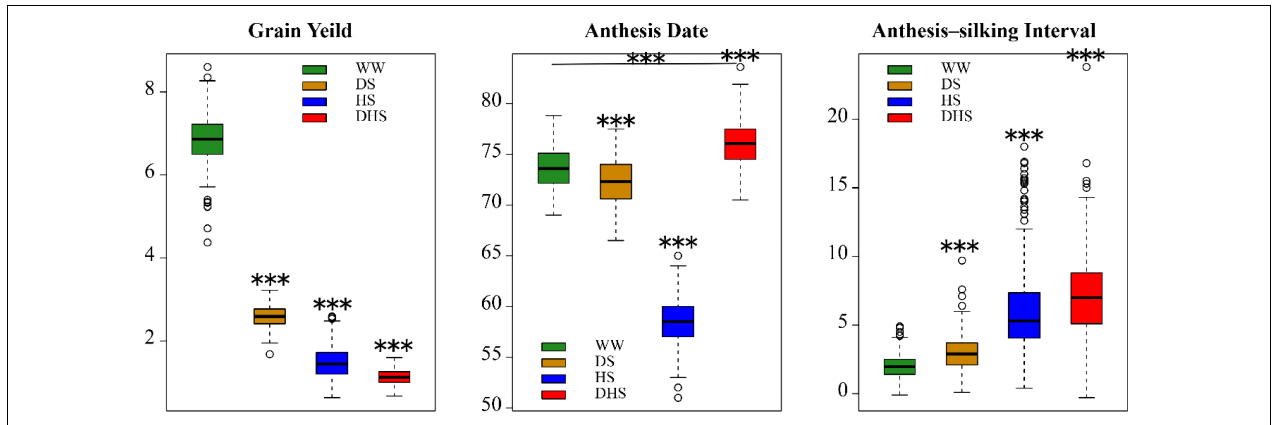
FIGURE 1 | The boxplots of the phenotypic distribution of all the 12 target trait-environment combinations between the three target traits, i.e., grain yield (ton/hectare); anthesis date (day); anthesis-silking interval (day), and the four evaluation conditions, i.e., well-watered (WW), drought stress (DS), heat stress (HS), and combined drought and heat stress